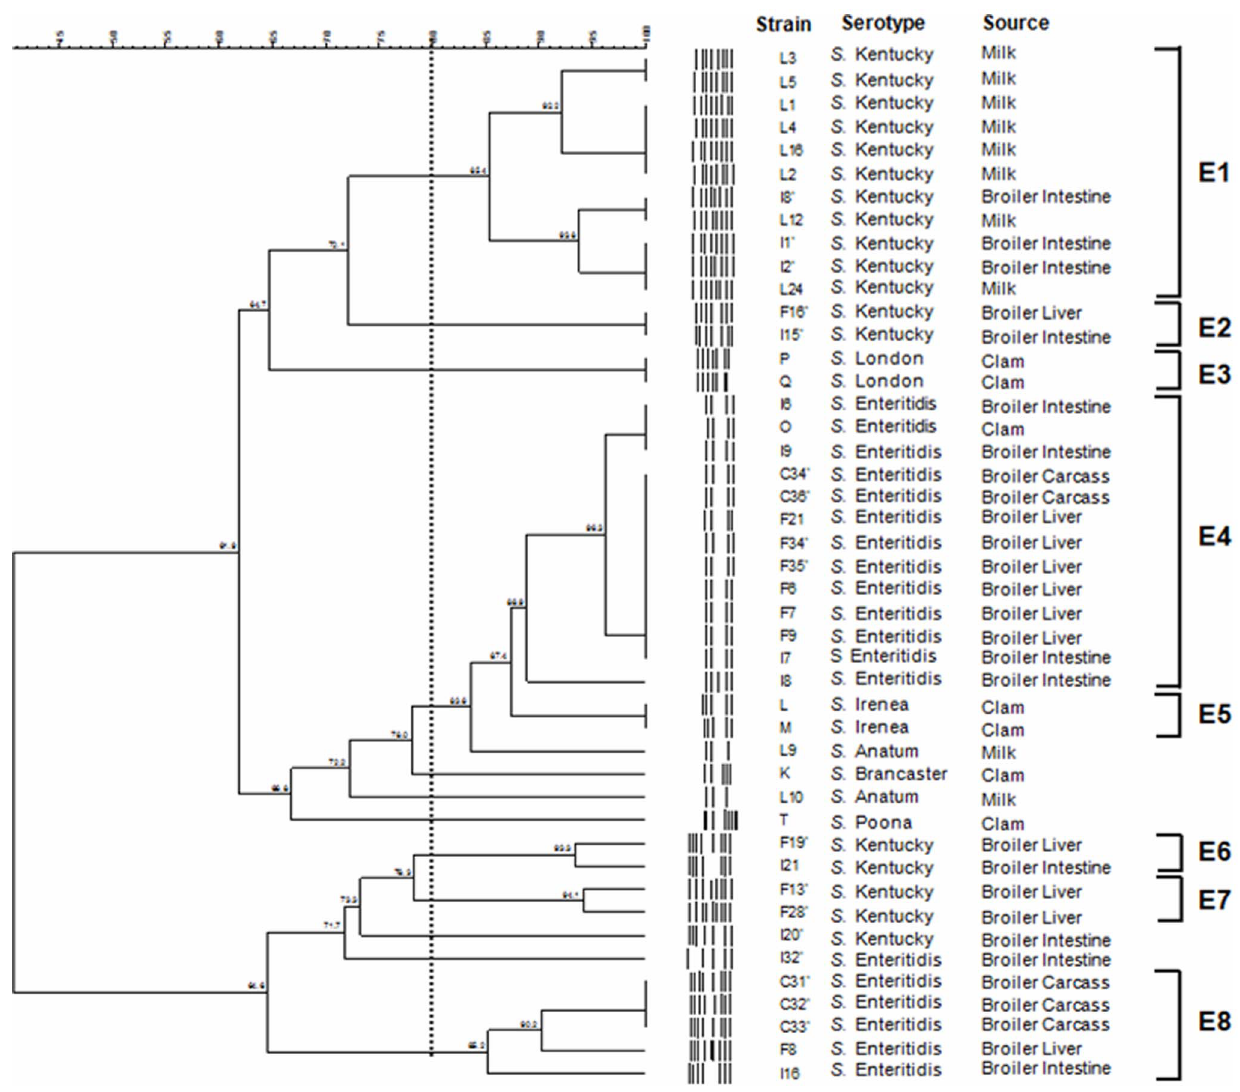
Figure 4. Genetic similarities of Salmonella strains isolated from clams, broilers and milk based on ERIC-PCR patterns. The dendrogram was generated by BioNumerics Software with the bande-matching coefficient of Dice and the UPGMA clustering. Genetic similarity between samples in duplicate is 80%.